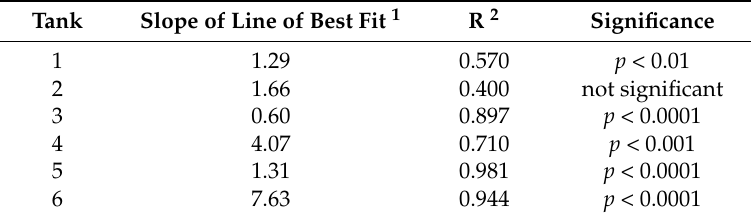
Table 5. Extent to which increases in conductivity in each tank are described by linear relationships with time 1 .